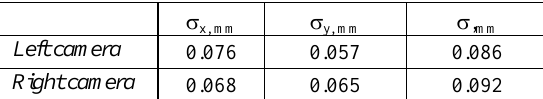
Table 1. Results of system calibration